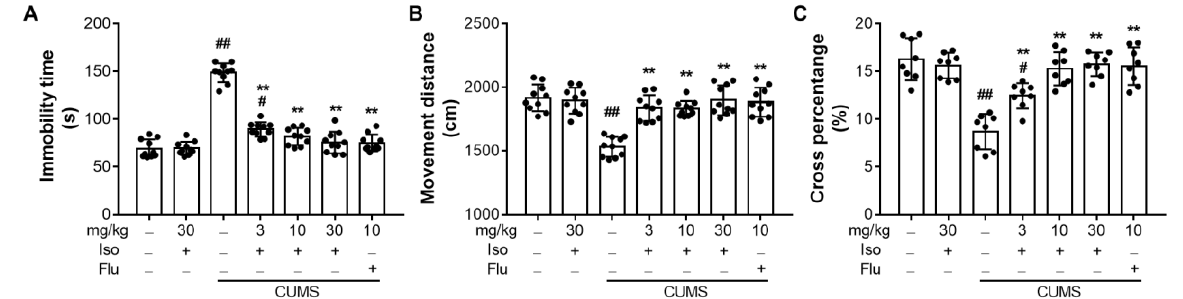
Figure 4. Isofraxidin increases CUMS-induced decrease of locomotor activity in OFT. ( A ) Total im- mobility time. ( B ) Total movement distances. ( C ) Percentage of time for mice reaching the central area. Data are presented as means ± SEM ( n = 10). The Control group was CUMS-free mice admin- istered with normal saline. CUMS group was CUMS mice. Significance was analyzed by one-way ANOVA followed by the Bonferroni correction. # p < 0.05 and ## p < 0.01, compared with the control group. ** p < 0.01, compared with CUMS group.